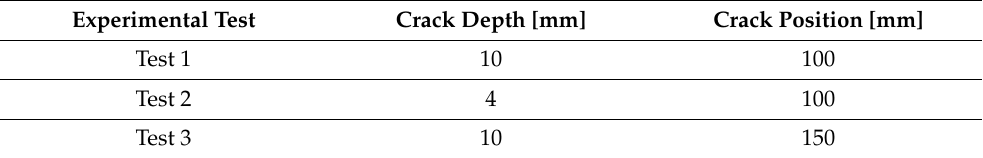
Table 1. Crack depths and positions investigated in the experimental